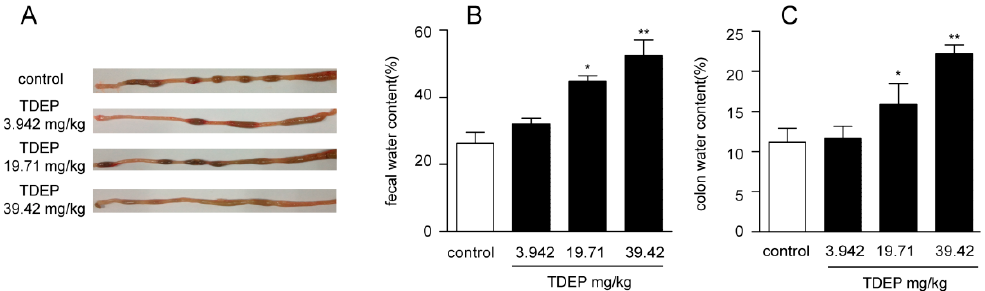
Figure 2. Diarrheal effect of TDEP. Macroscopic evidence of watery stool in the colon of TDEP-treated mice compared to that of control group ( A ); ( B ) TDEP dose-dependently (3.942, 19.71, 39.42 mg/kg) increased the fecal water content compared with the control group mice; ( C ) TDEP dose-dependently (3.942, 19.71, 39.42 mg/kg) increased the colon water content compared with the control group mice. Data are represented as the mean ± SD. * p < 0.05, ** p < 0.01 vs. control group, respectively. n = 6 in each group and each assay was repeated six times.